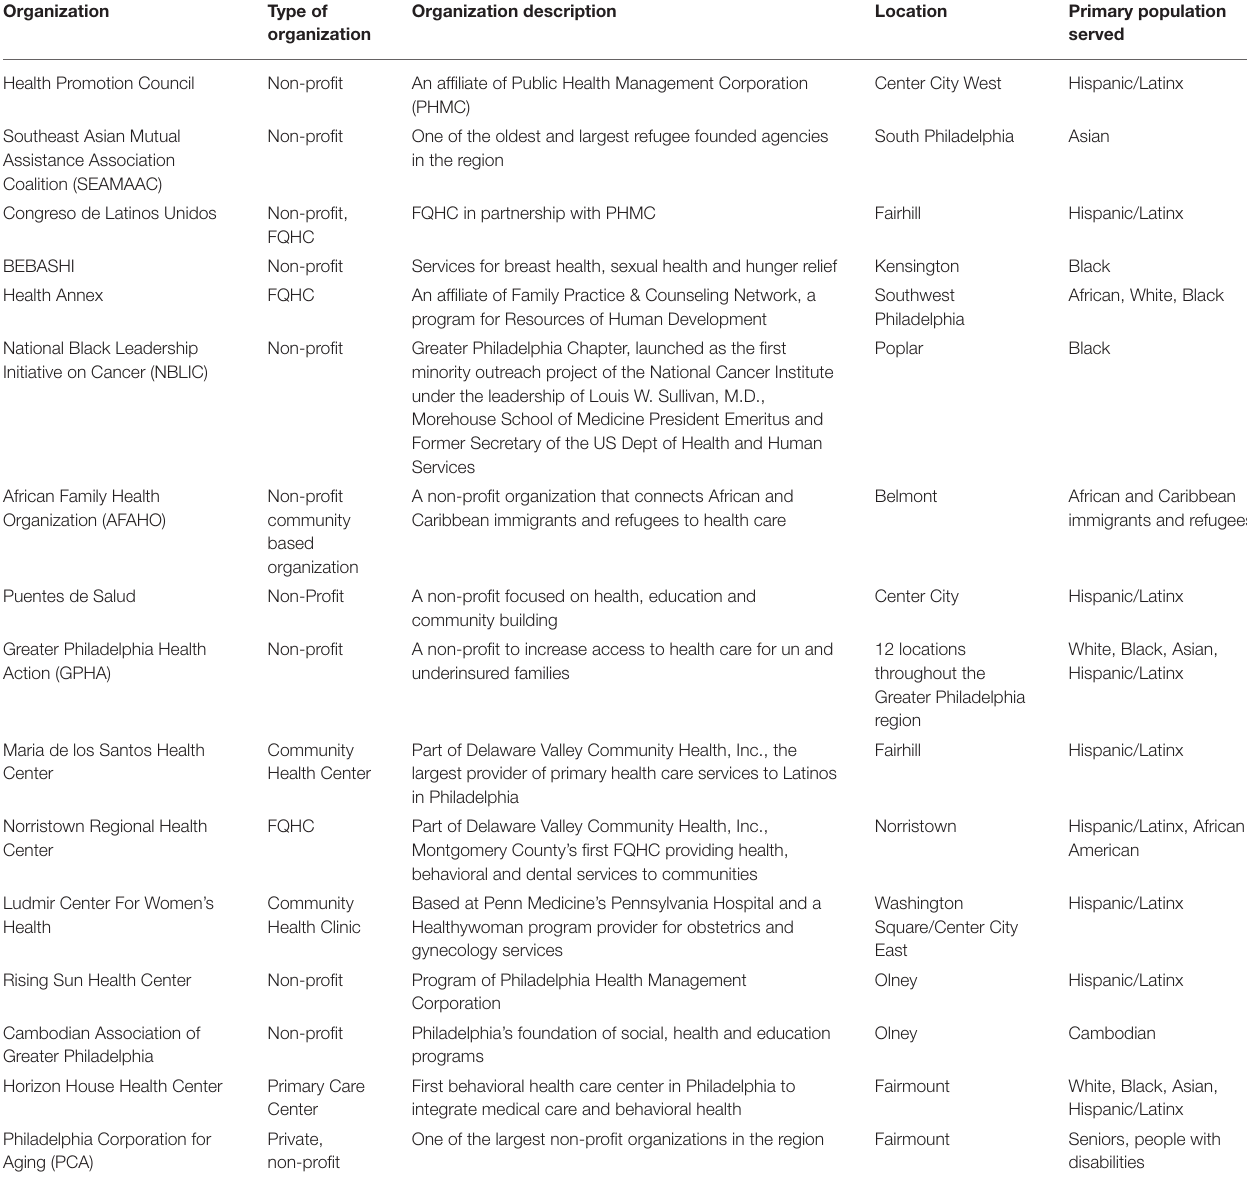
TABLE 1 | Penn Medicine breast health initiative community partner